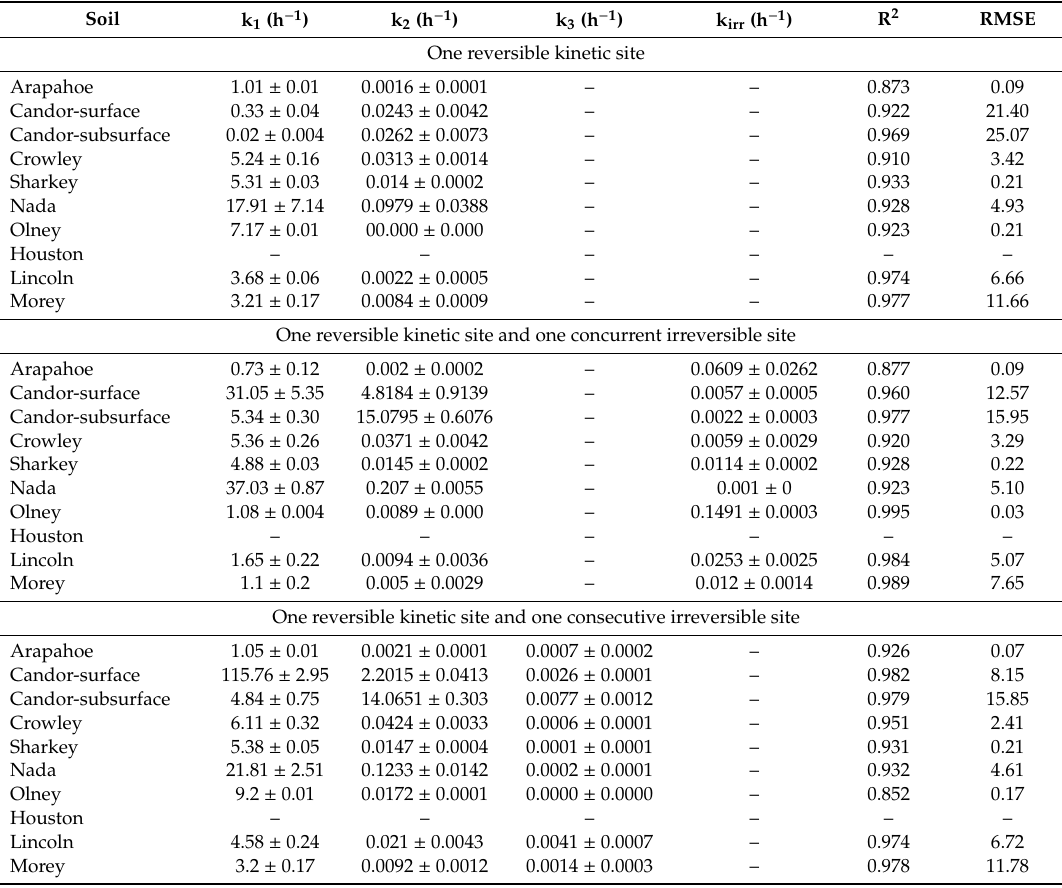
Table 4. Multireaction kinetic model (MRM) parameter estimates for Pb sorption / desorption of reaction rates (k 1 , k 2 , k 3 , and k irr ) ± their standard errors, with coe ffi cient of determination (R 2 ) and root mean square error (RMSE)